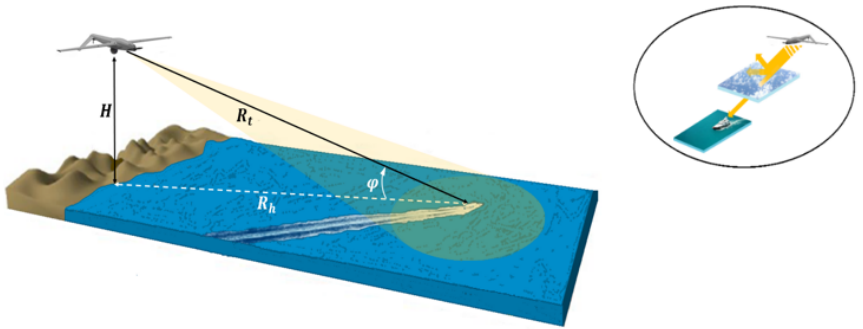
Figure 2. Forward-looking maritime radar located on UAV.